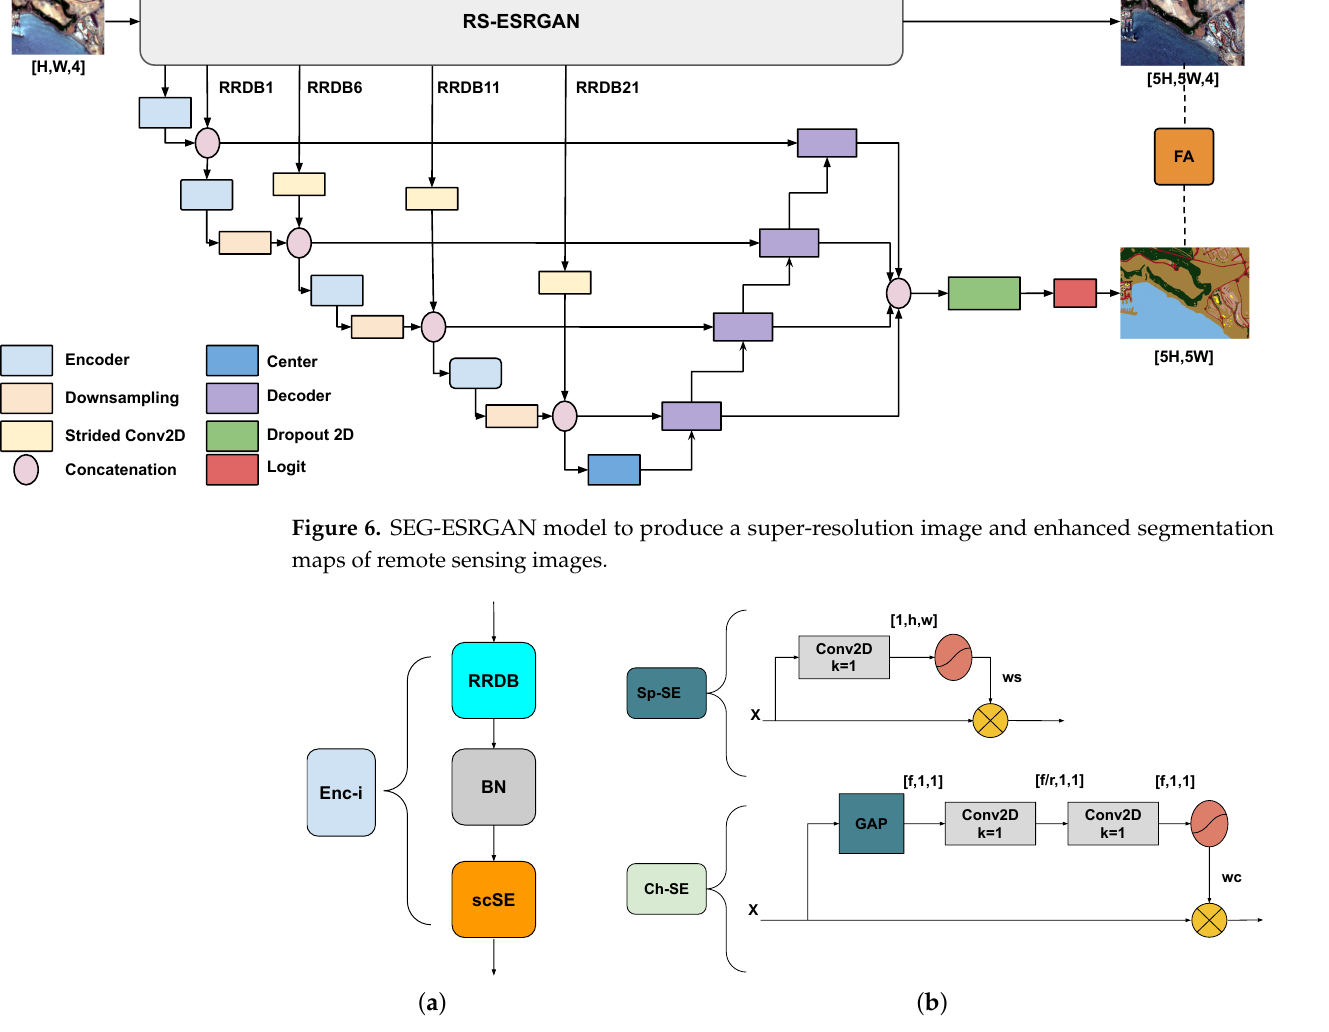
Figure 7. ( a ) Encoder sub-block of the SEG-ESRGAN segmentation branch and ( b ) Attention blocks that compose the scSE